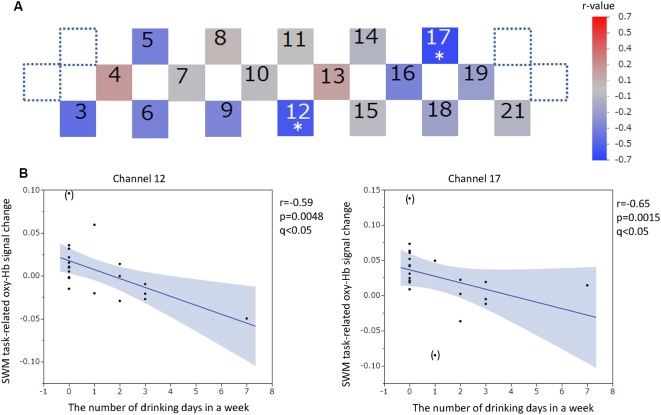
SWM task-related oxy-hemoglobin signal changes and the number of drinking days in 1 week. Levels of correlation are illustrated by colored squares (A). The color spectrum bar indicates the r-value scale. Channels with statistical significance even after FDR correction are indicated by an asterisk (q < 0.05). Scatter plots with regression lines and 95% confidence intervals represent the significant channels (B). Outliers are indicated in parentheses. SWM, Spatial working memory; oxy-Hb, oxy-hemoglobin.